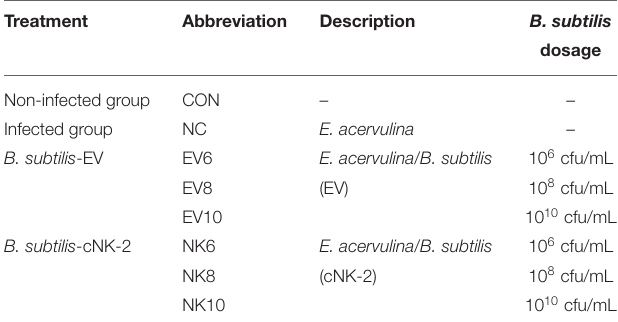
TABLE 1 | Treatment and Eimeria challenge infection.